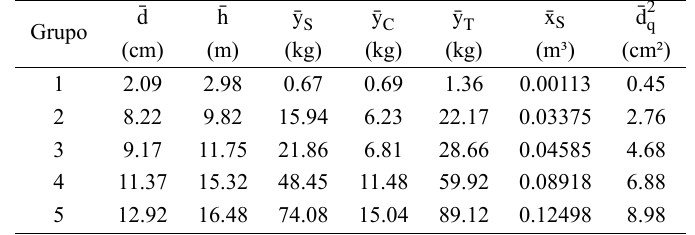
Variable averages of black wattle trees: diameter at breast height ( ¯d ), total height ( ¯h ), stem biomass ( ¯ y S ), crown biomass ( ¯ y C ), total biomass ( ¯ y T ), stem volume ( ¯ x S ) and quadratic mean diameter ( ¯ d 2 q ) of stands in Rio Grande do Sul, Brazil.